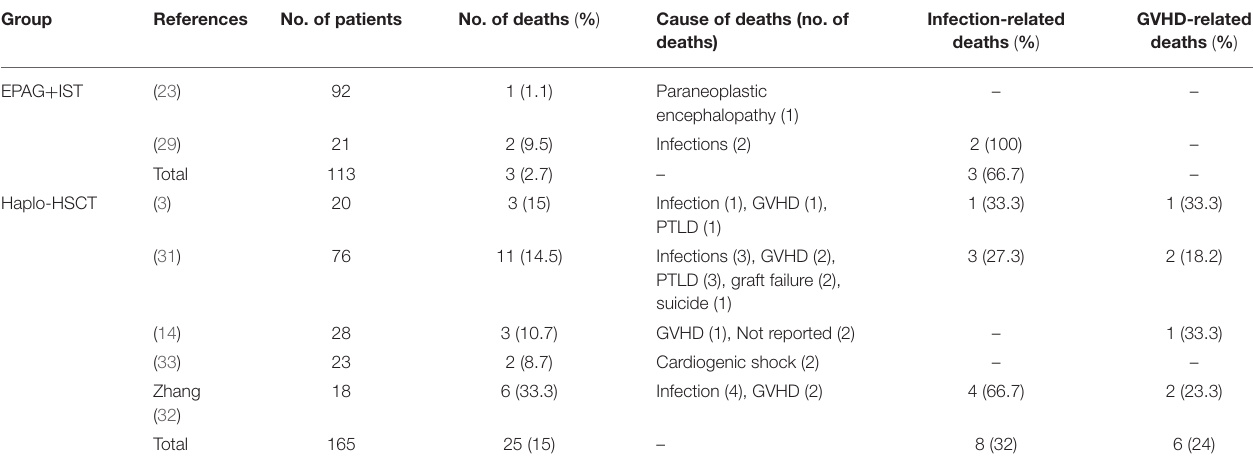
TABLE 2 | Summary of the cause of deaths in EPAG + IST and haplo-HSCT group. Group